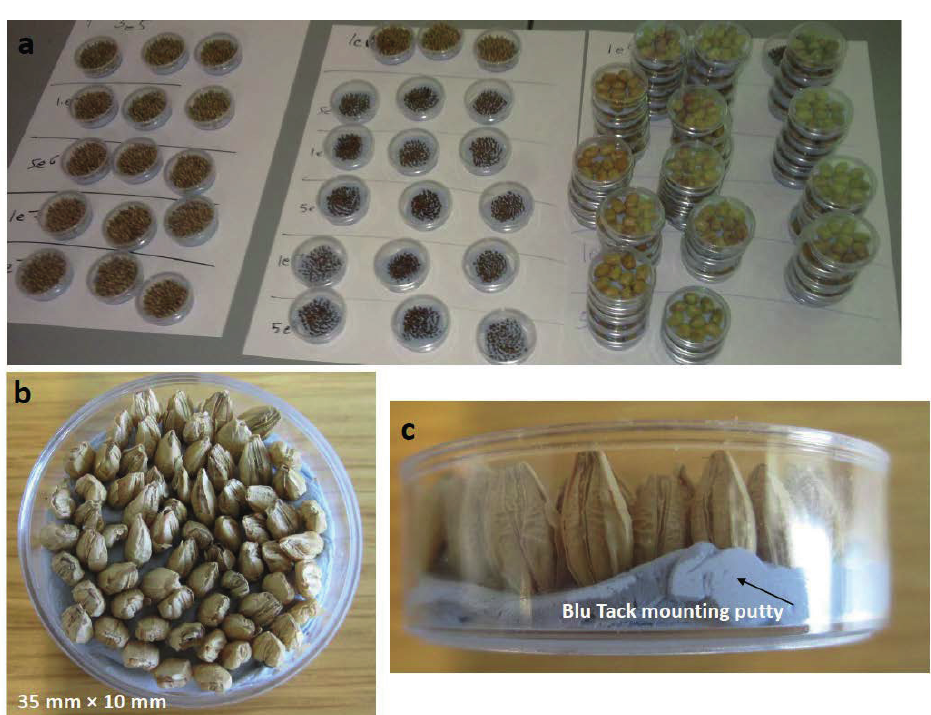
Fig. S1. Dry seed preparation for ion beam irradiation. (a) overview on all three species, (b) view from above and (c) view from side in